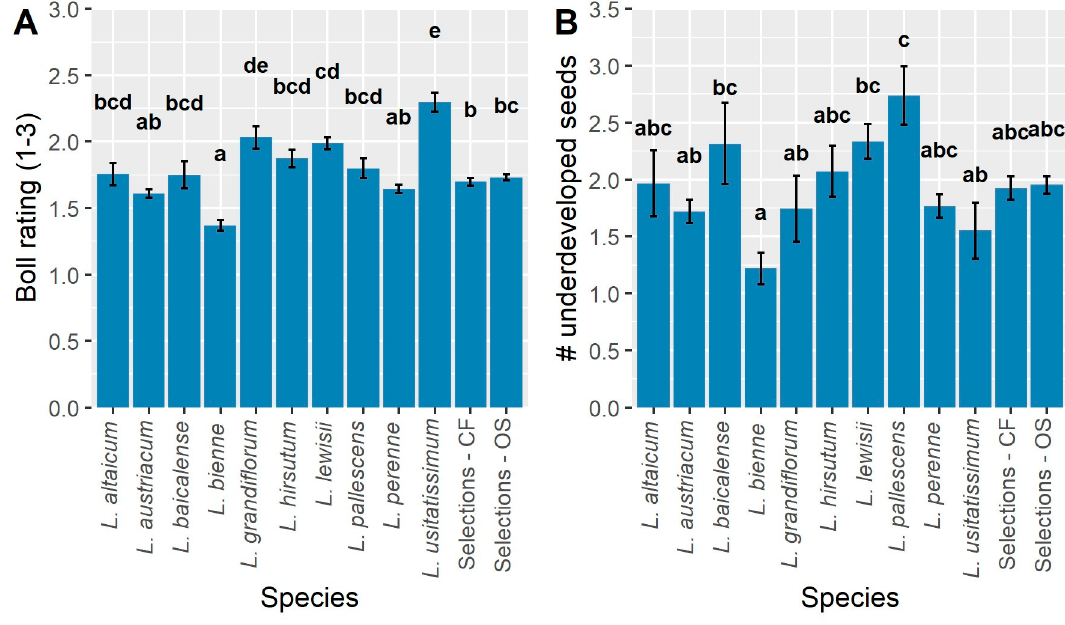
Figure 6. Comparison of wild flax (Linum) species with CF and OS selections for mean ± S.E. Year 1 trait values related to oilseed ideotype: ( A ) boll rating (1–3; fully dehiscent to non-shattering) and ( B ) # underdeveloped seeds per capsule. Means separations (5% HSD): letters above columns.